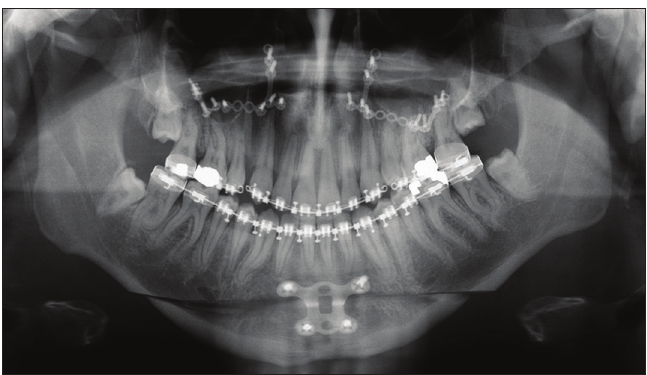
Figure 10. Post-surgical